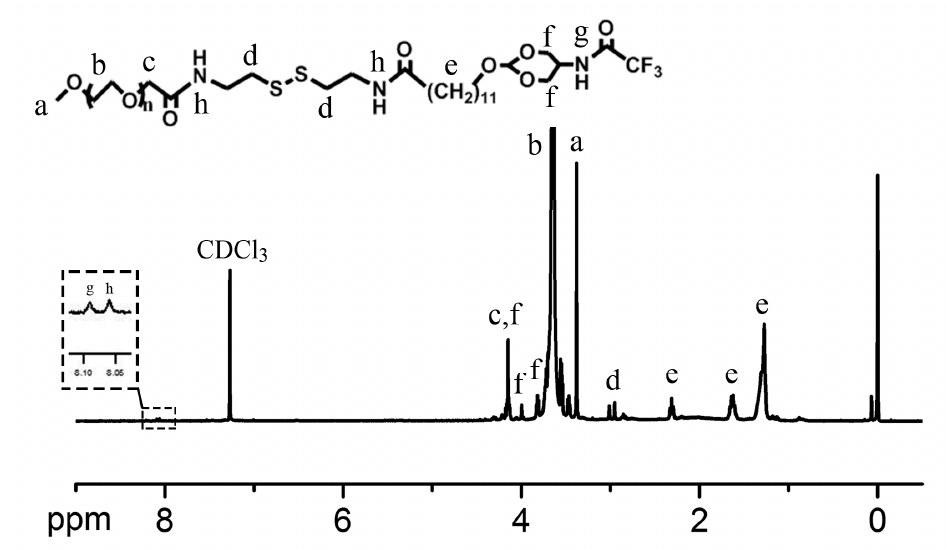
Figure 2. 1 H NMR spectra of PCT polymers in CDCl 3 .